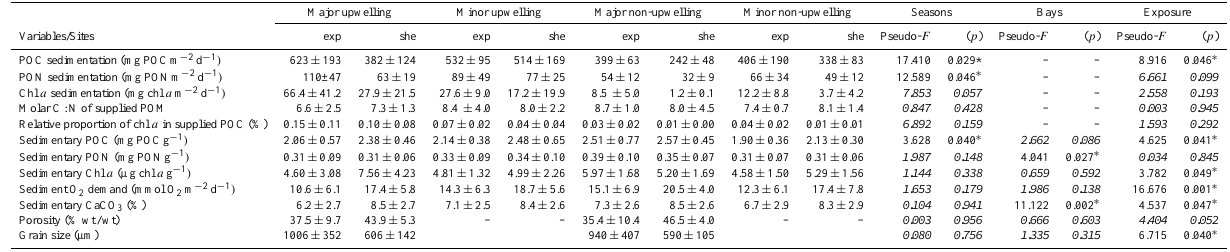
Table 1. Seasonal means of sedimentary parameters and univariate analyses. Significant PERMANOVA results are indicated by asterisks with ∗ for significant ( p < 0.05). Not significant values are displayed in italics. Abbreviations: exposed site (exp), sheltered site (she), particulate organic carbon (POC), particulate organic nitrogen (PON), chlorophyll a (chl a ), and calcium carbonate (CaCO 3 ) . Majorupwelling Minorupwelling Majornon-upwelling